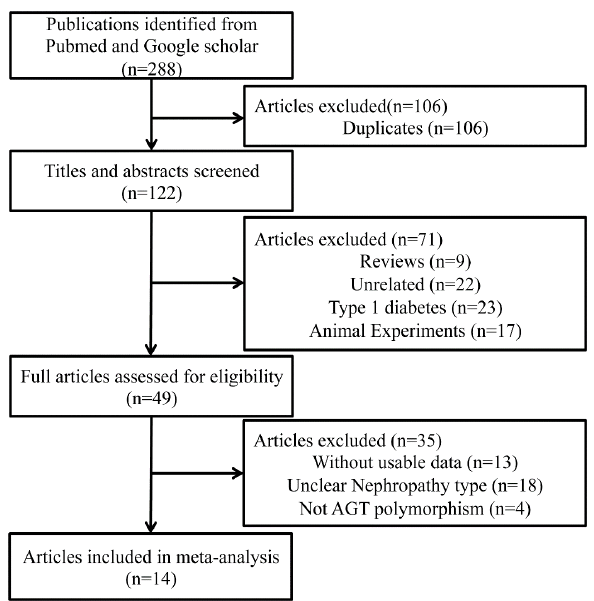
Figure 1. Process of Study selection for